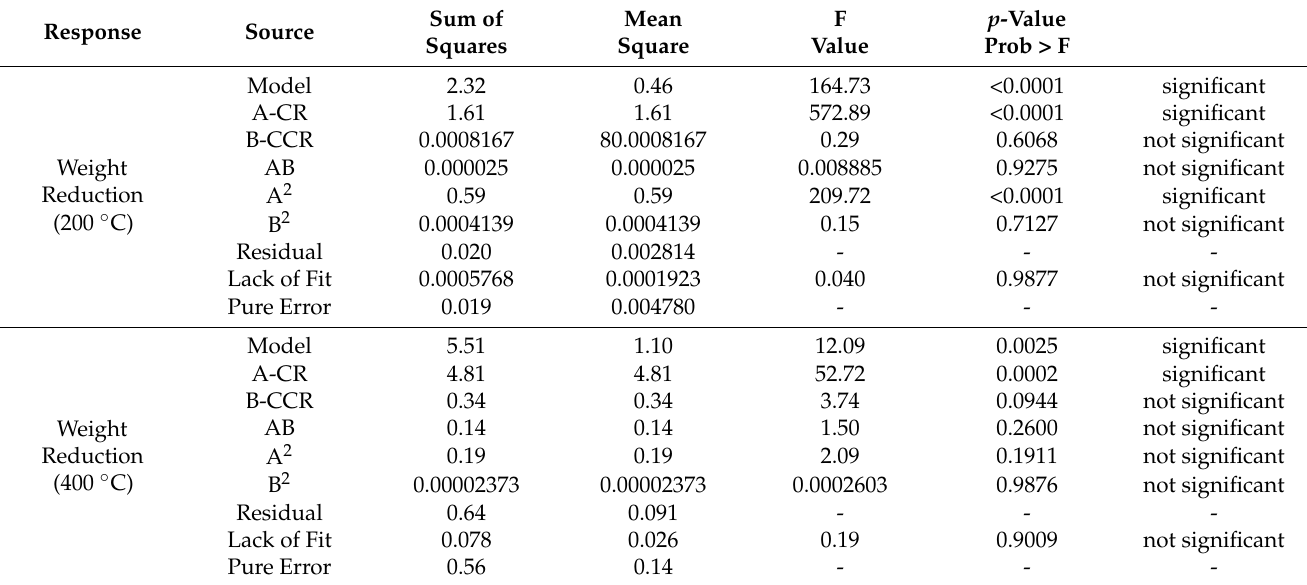
Table 9. ANOVA for weight reduction due to elevated temperature